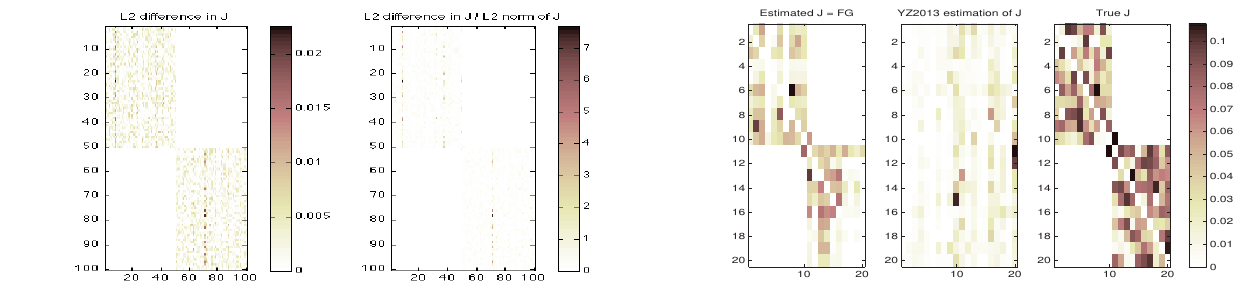
Figure 5: Left: our proposed estimation. Center: estimation following [29]. Right: true J